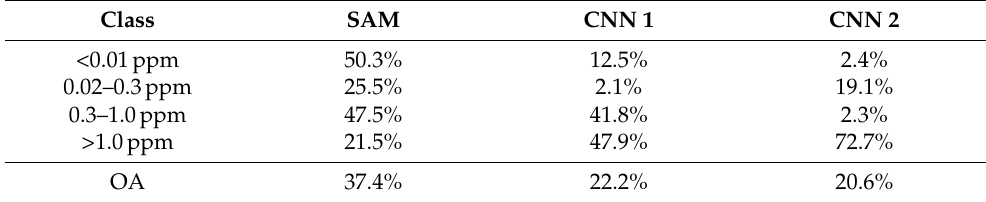
Table 2. Per-class accuracy and overall accuracy (OA) of classification relative to reference data for the four grade classification problem. CNN 1 and CNN 2 refer to the two validation splits.